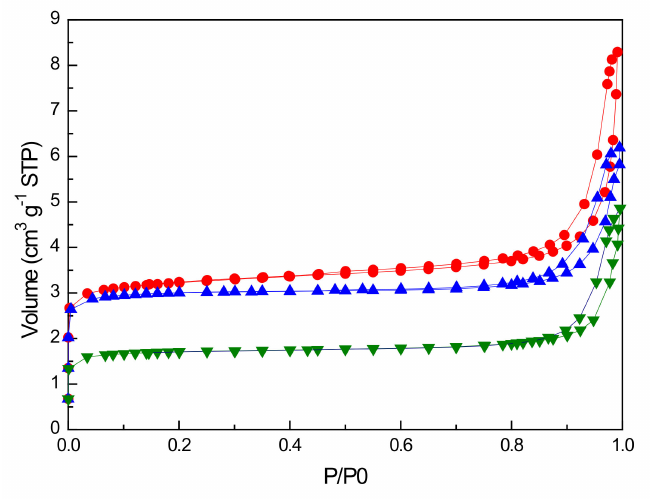
Figure 7. Nitrogen adsorption isotherm at 77 K for V f (red • ), V r400 (blue (cid:78) ), and V r450 (green (cid:72)